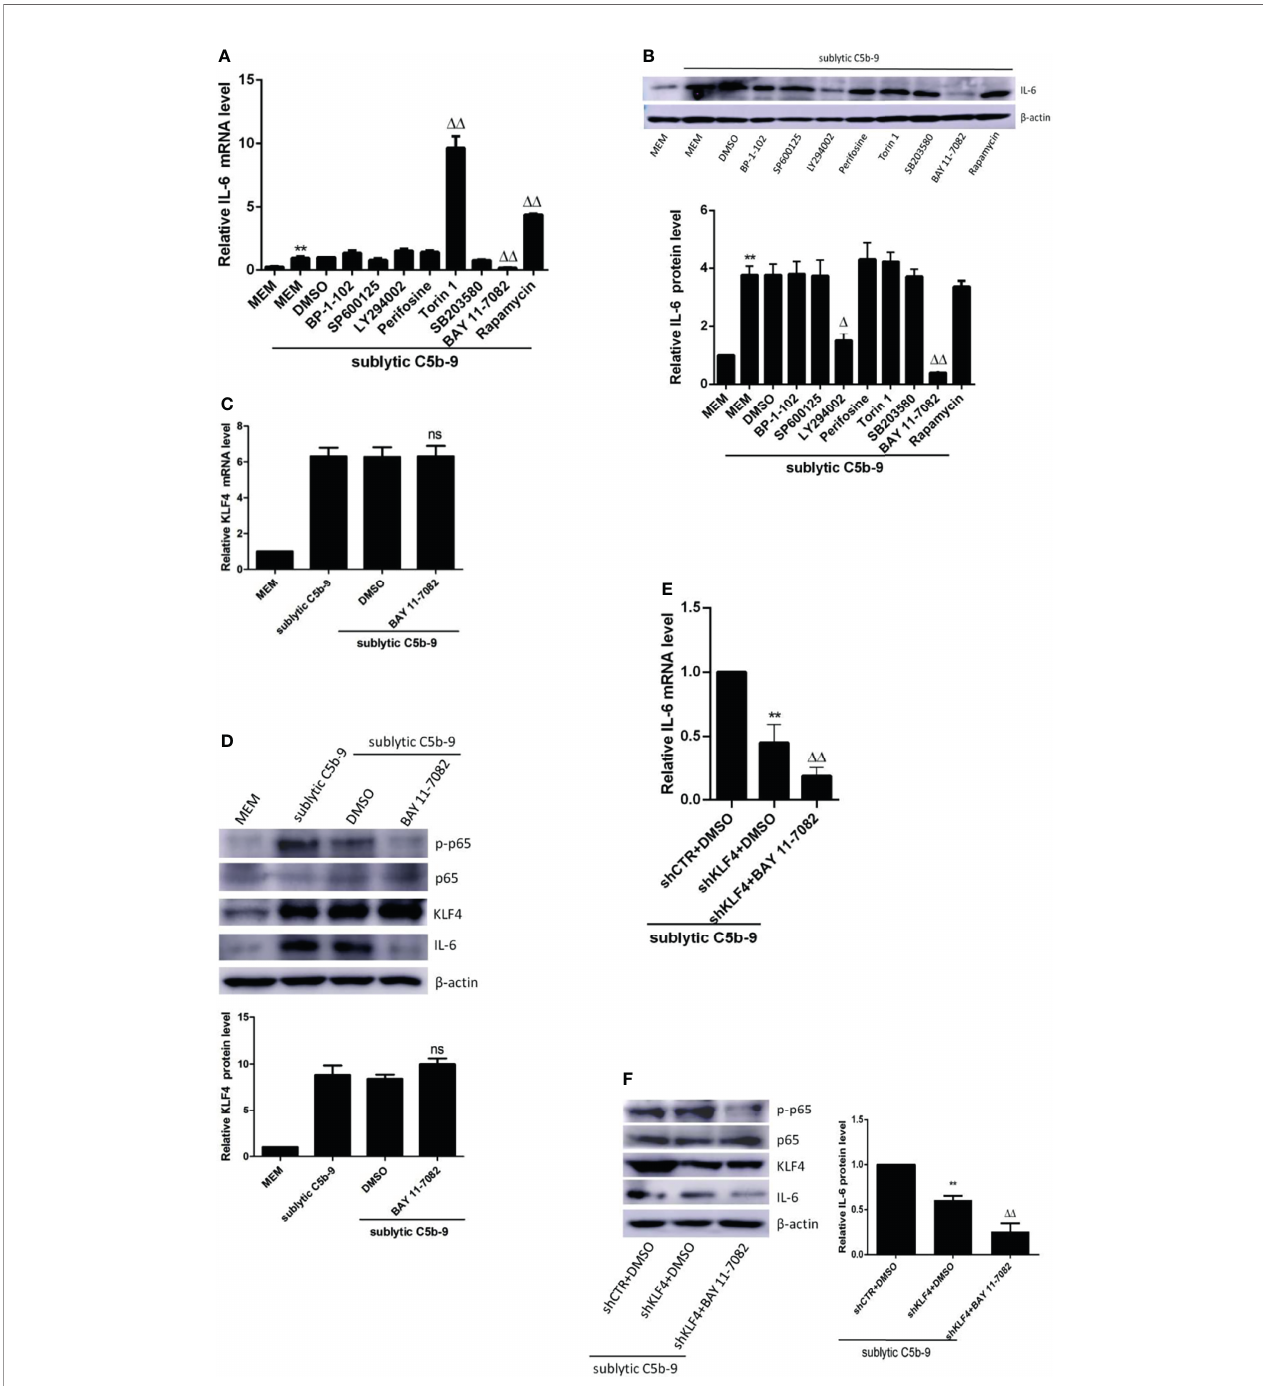
FIGURE 4 | Effect of NF- k B signaling pathway on KLF4 expression. (A, B) GMCs were pretreated with inhibitors of BP-1-102, SP600125, LY294002, perifosine, Torin 1, SB203580, BAY 11-7082, or rapamycin at the same dose (10 m M) for 30 min and then stimulated with sublytic C5b-9 for 3 h. qPCR (A) and IB (B) analyses of IL-6 (**p < 0.01 vs. MEM; D p < 0.05, DD p < 0.01 vs. DMSO + sublytic C5b-9). (C, D) GMCs were pretreated with BAY 11-7082 for 30 min and then stimulated with sublytic C5b-9 for 3 h. qPCR (C) and IB (D) analyses of KLF4, p-NF- k B p65, NF- k B p65, or IL-6 (ns represents p > 0.05 vs. DMSO + sublytic C5b-9). (E, F) GMCs were transfected with shCTR or shKLF4 plus DMSO or BAY 11-7082 treatment followed by sublytic C5b-9 attract for 3 h. qPCR (E) and IB (F) analyses of IL-6, p-NF- k B p65, NF- k B p65, or KLF4 (*p < 0.05, **p < 0.01 vs. shCTR + DMSO + sublytic C5b-9; DD p < 0.01 vs. shKLF4 + DMSO + sublytic C5b-9). Data are representative of three independent experiments with similar results or are shown as mean ± SD from three independent experiments. GMCs, glomerular mesangial cells; IB, immunoblotting; MEM, minimum essential medium; DMSO, dimethyl